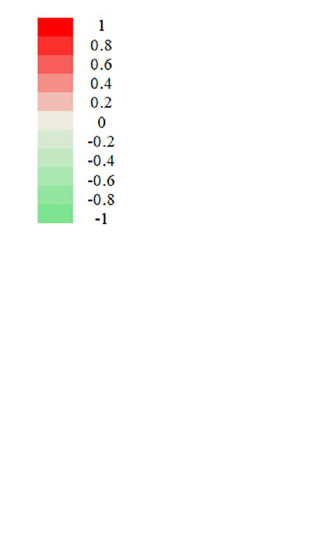
germplasm Nos. 1, 7, and 17, while subclass B consisted of germplasm Nos. 2, 3, 4, and 5. The fourth category included 8 high-oleic rape germplasms, which included germplasm Nos. 6, 8, 9, 13, 14, 21, 24, and 26, respectively, accounting for 27% of the total. The characters of the four groups were calculated, and the results of each character are shown in Table 3. The first group of materials contained erucic acid, but it was still at the "dou- ble low" level, and the incidence index was low. The plant yield of the second group was higher than that of other groups, but the incidence rate of Sclerotium disease increased. The oil con- tent and crude protein content of this group were high in the third group. The four varieties that have been put into production belonged to this group. Oleic acid content of the fourth group was higher than that of other groups, but the incidence rate of viral disease increased.